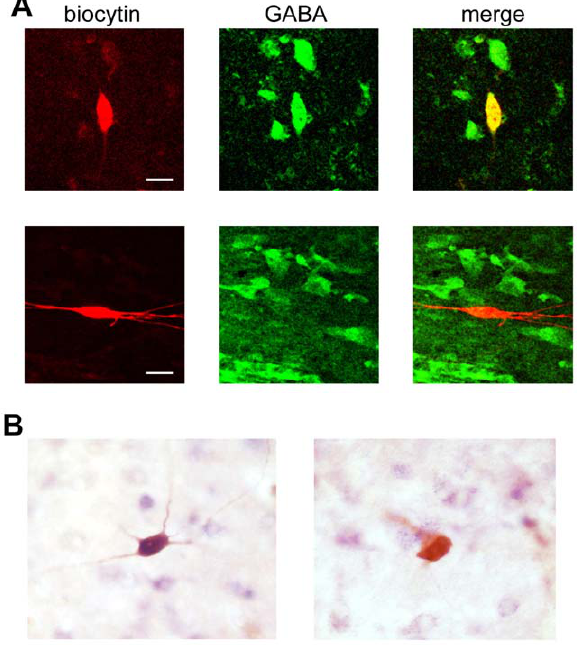
Figure 2. Identification of GABA neurons following whole cell recordings. (A) Example where immunocytochemistry against GABA (green) was used to identify GABAergic VTA neurons filled with biocytin (red). (Top row) An example GABA( + ) recorded cell, and (Lower row) an example GABA( 2 ) recorded cell. (B) In other cases we used in situ hybridization against GAD65/67 mRNA to test whether recorded neurons were GABAergic. In these examples of positive colabeling (left) and a lack of colabeling (right), filled cells are labeled with DAB (brown), and in situ label is visualized with digoxin (purple).